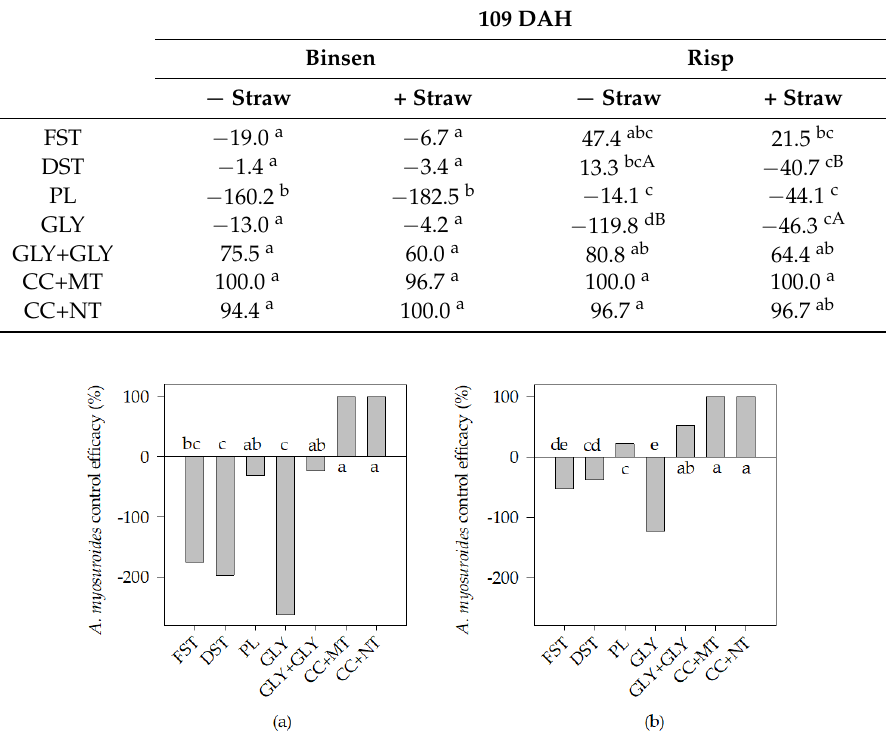
Table 4. Average Alopecurus myosuroides Huds. control efficacy of flat soil tillage (FST), deep soil tillage (DST), ploughing (PL), single glyphosate application (GLY), dual glyphosate application (GLY+GLY), cover crop mixture + mulch-till (CC+MT), and cover crop mixture + no-till (CC+NT) treatments in combination with the presence (+) or absence ( − ) of straw 109 days after harvest (DAH) for the two trials at the fields Binsen and Risp. Different small letters within one column show significant differences according to Tukey–HSD test ( p ≤ 0.05). Means with identical letters do not differ significantly. Different capital letters show significant differences within one experiment and within one treatment according to the presence or absence of straw. Means with no capital letter do not differ according to Tukey–HSD test.